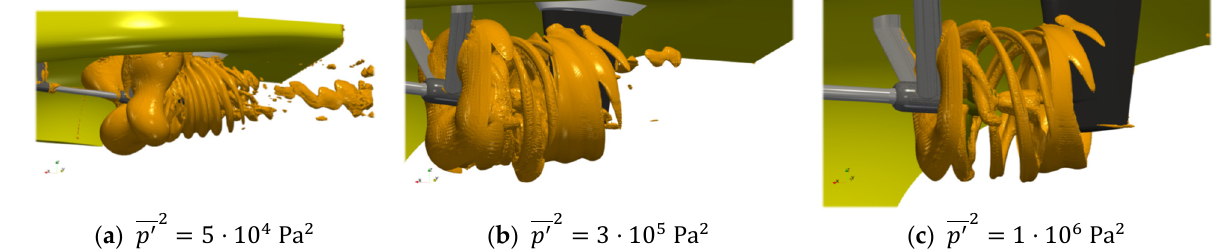
Figure 15. Second order statistical moments of pressure time history.